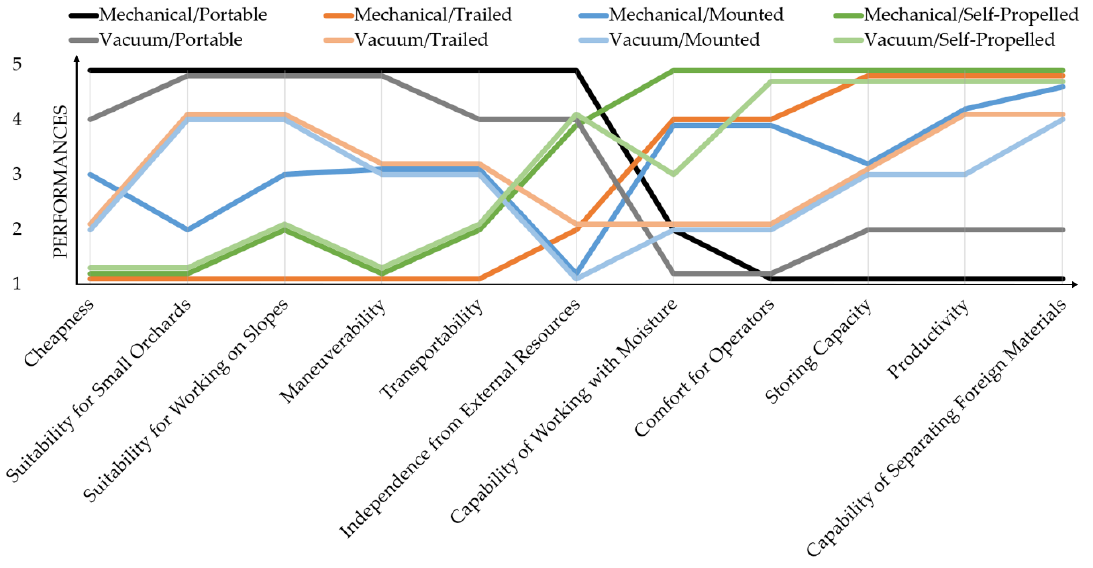
Figure 6. Value curves for the eight categories of harvesting machines for shell fruits.